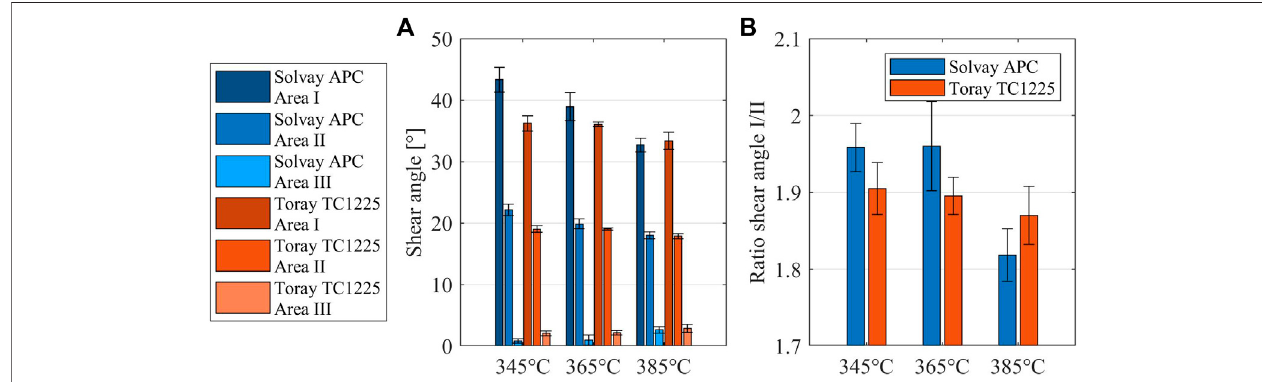
FIGURE9| Deformation distribution fordifferenttest temperatures, averaged over three test ratesand three repetitions. (A) Mean shear angle forareasI,II, and III. (B) Ratio between shear angles in areas I and II.